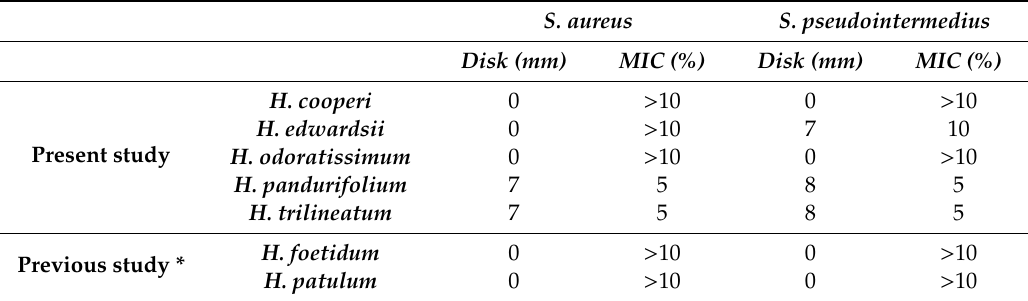
Table 6. Antibacterial activity of the tested EOs of Helichrysum species. MIC, minimum inhibitory